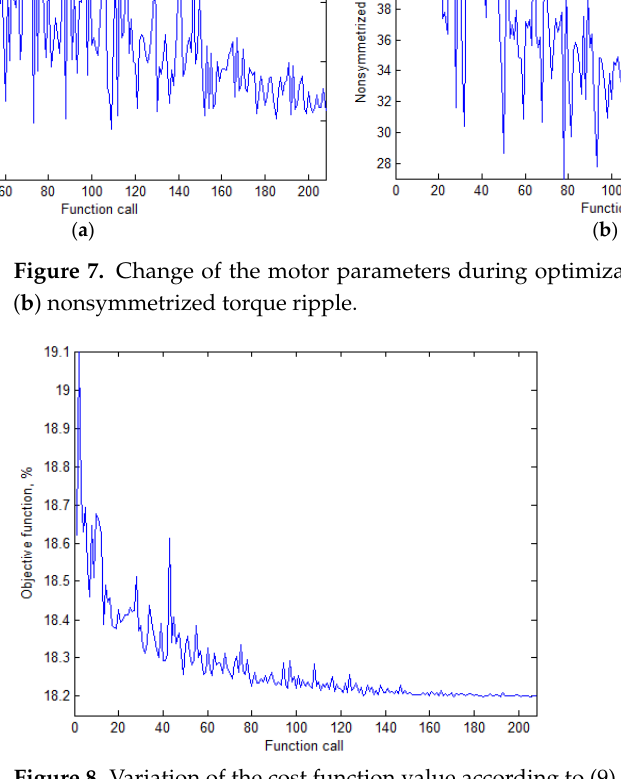
Figure 8. Variation of the cost function value according to (9) during optimization. Figures 9 and 10 depict the geometry and induction value in the SHM before and after optimization. Table 4 shows the results of optimization.